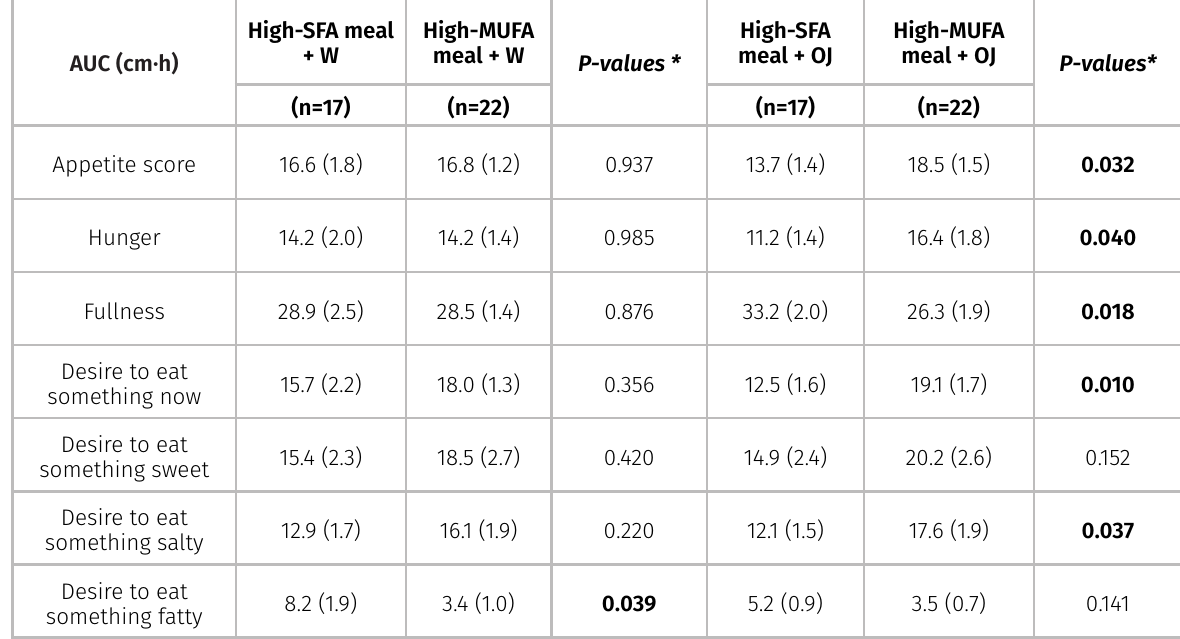
Table II. Area under curve of subjective appetite sensations after high-fats meals followed by water and orange juice up to 5 hours.